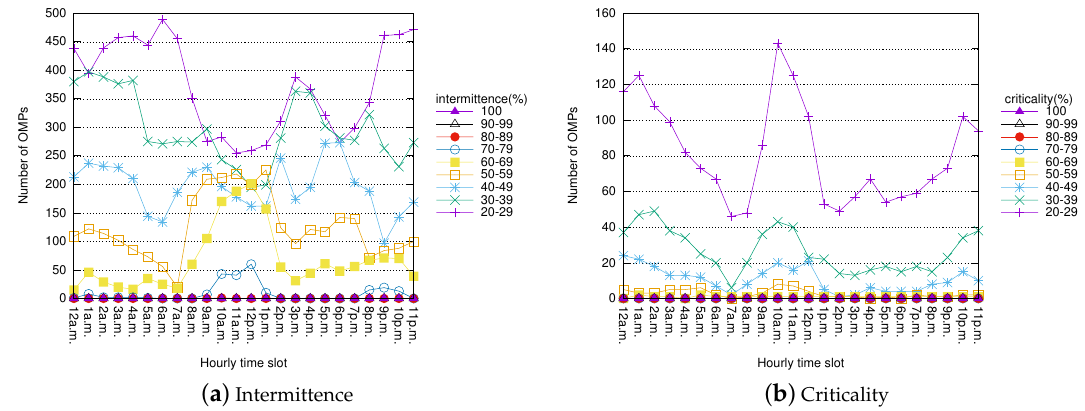
Figure 4. Bicing (Barcelona). Hourly distribution of the number of OMP and their corresponding levels of intermittence/criticality. maxdist = 0.5 km. time slot size = 1 h. full-th = 3.